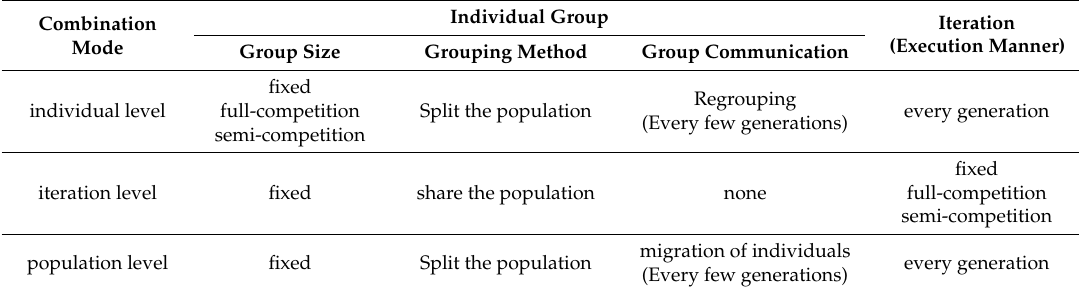
Table 2. Combination Scheme